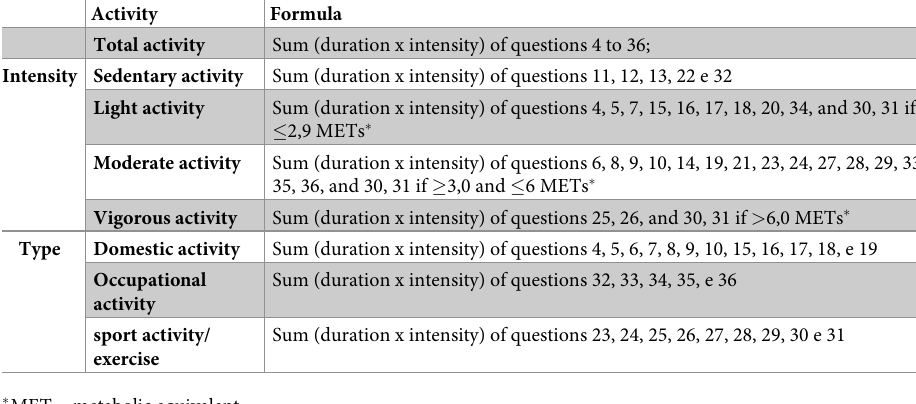
Table 1. Formulas for weekly energy calculation using the